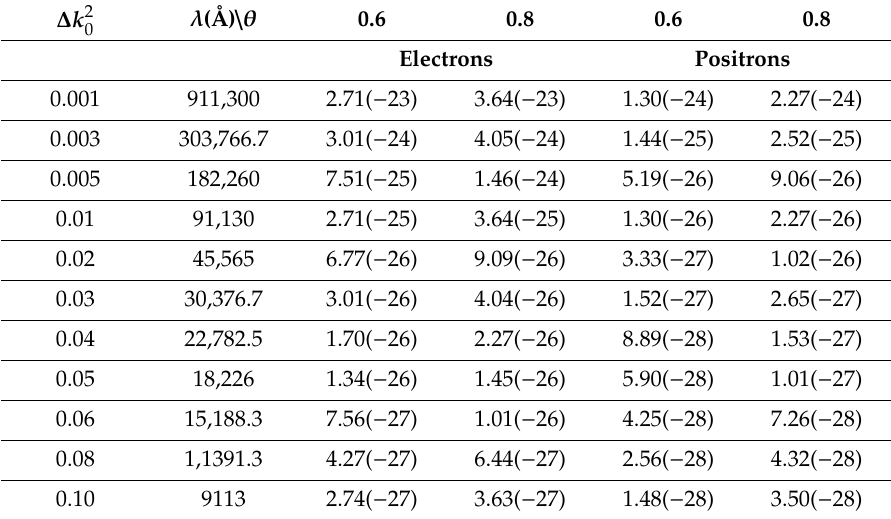
Table 23. Maxwellian averaged absorption coe ffi cients (cm 4 / dyne) for free–free transitions involving electrons and hydrogen atoms, and positrons and hydrogen